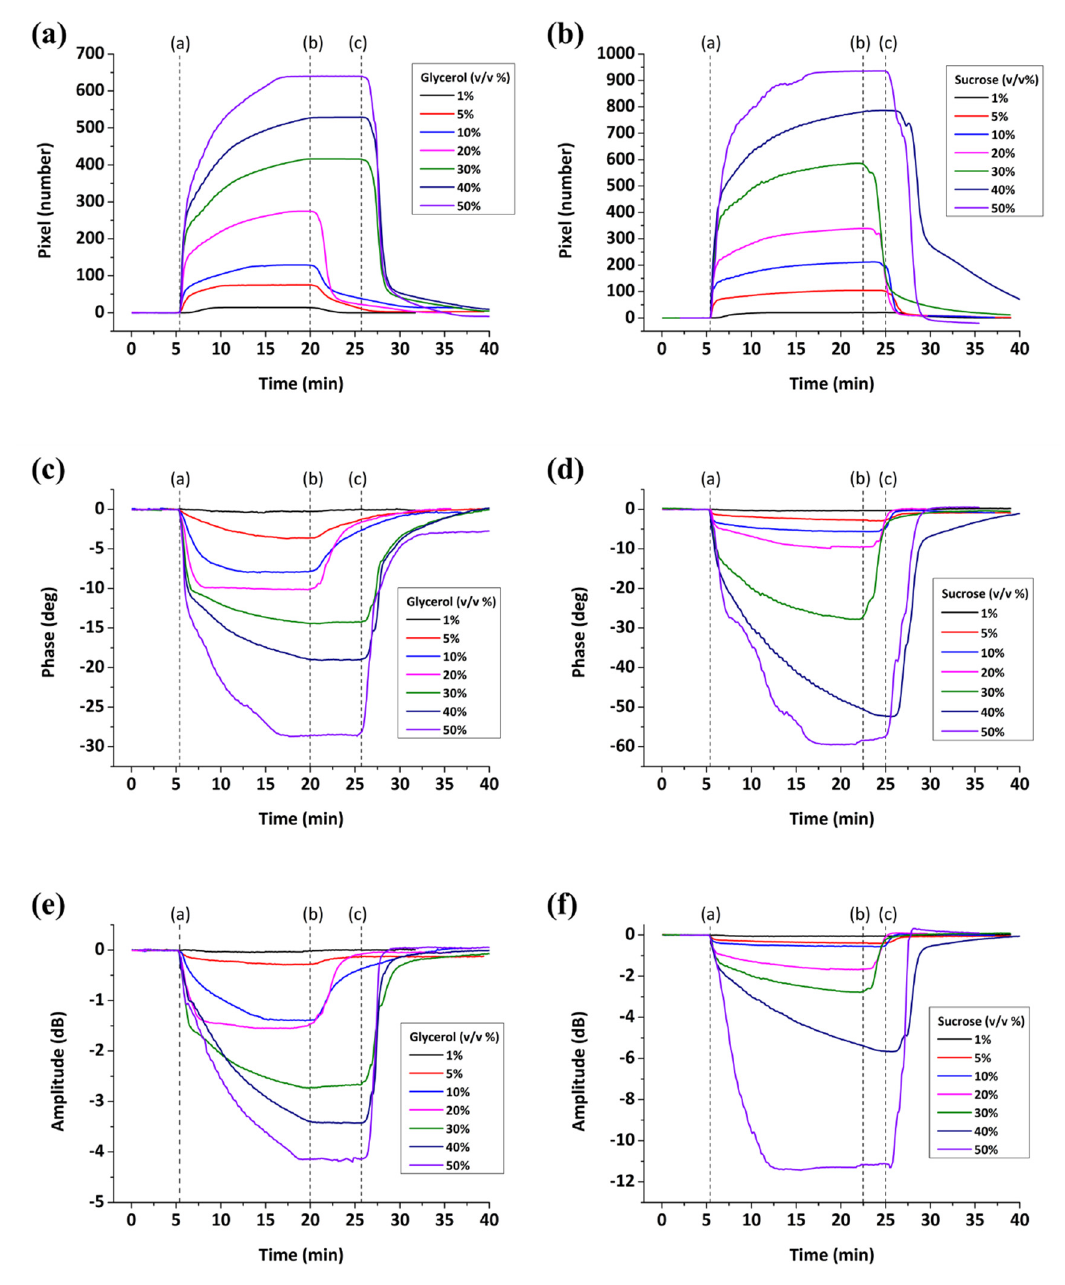
Figure 10. Real-time response upon glycerol / water and sucrose / water solutions loading on the sensor surface: SPR ( a , b ); phase ( c , d ); and amplitude ( e , f ).